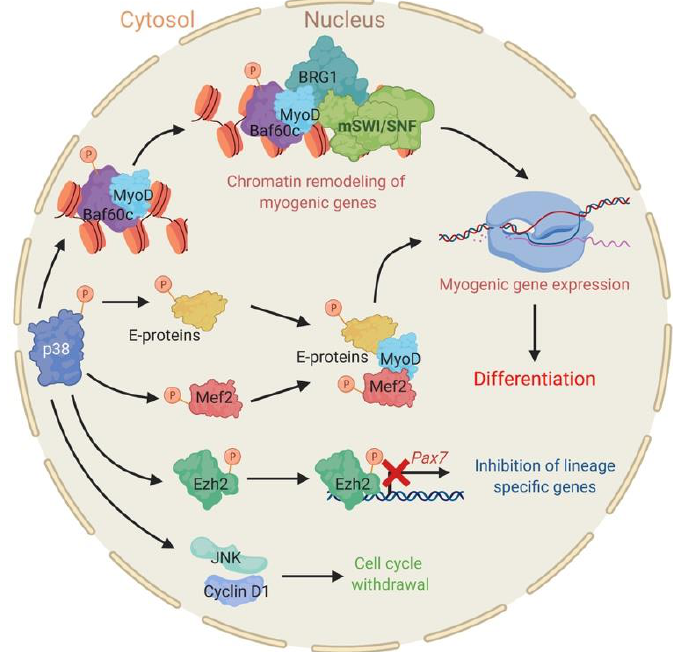
Figure 1. P38 has pleiotropic e ff ects during skeletal muscle di ff erentiation. Phosphorylation Figure 1. p38 has pleiotropic effects during skeletal muscle differentiation. Phosphorylation of of transcription factors (TFs) (E-proteins, Mef2) and the mSWI / SNF subunit BAF60c by p38 transcription factors (TFs) (E-proteins, Mef2) and the mSWI/SNF subunit BAF60c by p38 enables enables expression of myogenic genes and di ff erentiation. P38-dependent phosphorylation of Ezh2 expression of myogenic genes and differentiation. p38-dependent phosphorylation of Ezh2 downregulates the expression of Pax7 . P38 also induces cell cycle withdrawal by activating c-Jun downregulates the expression of Pax7 . p38 also induces cell cycle withdrawal by activating c-Jun N-terminal kinase (JNK) and Cyclin N-terminal kinase (JNK) and Cyclin D1.